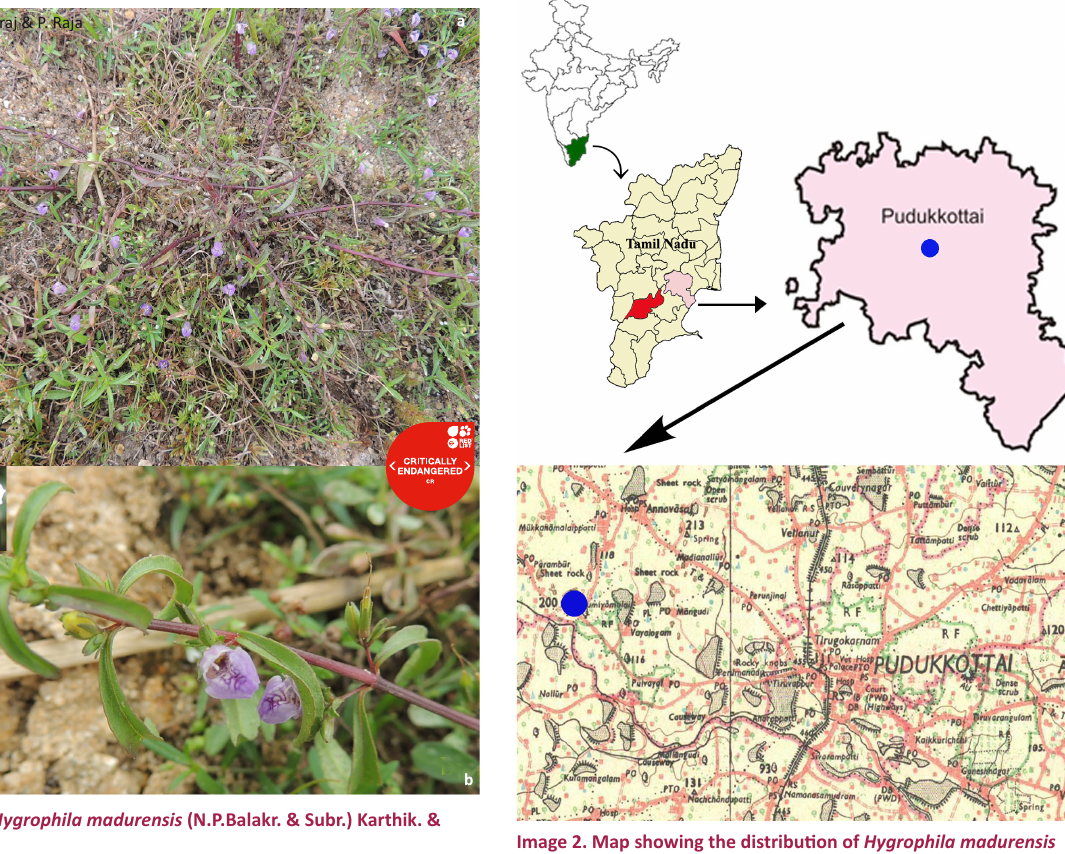
Image 2. Map showing the distribution of Hygrophila madurensis at present